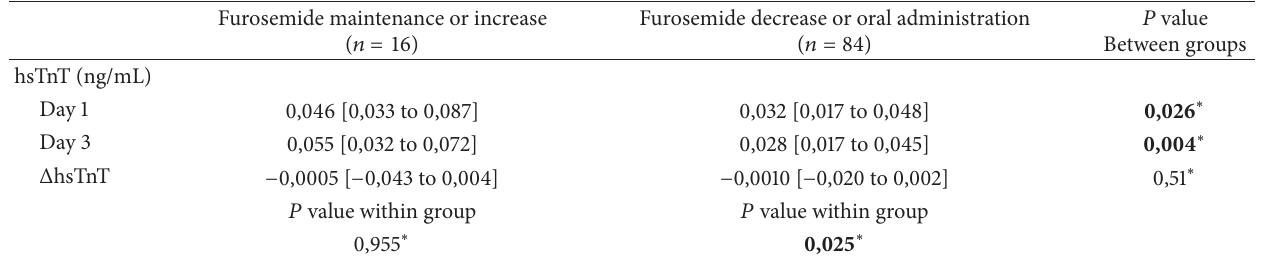
Table 2: Comparison of TnT levels between patients who responded to diuretic therapy versus patients who needed to increase diuretic dose. 𝑃 value Furosemide maintenance or increase Furosemide decrease or oral administration (𝑛 = 16) (𝑛 = 84) Between groups hsTnT (ng/mL) 0,046 [0,033 to 0,087] 0,032 [0,017 to 0,048] 0,026 ∗